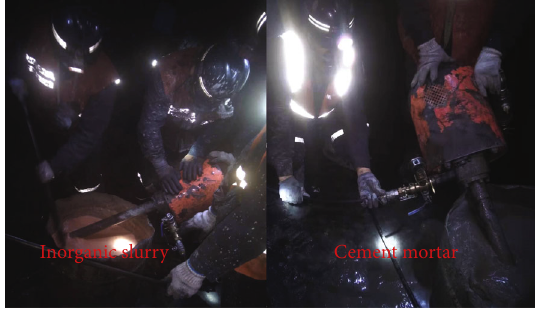
Figure 13: Implementation of borehole grouting with di ff erent kinds of sealing